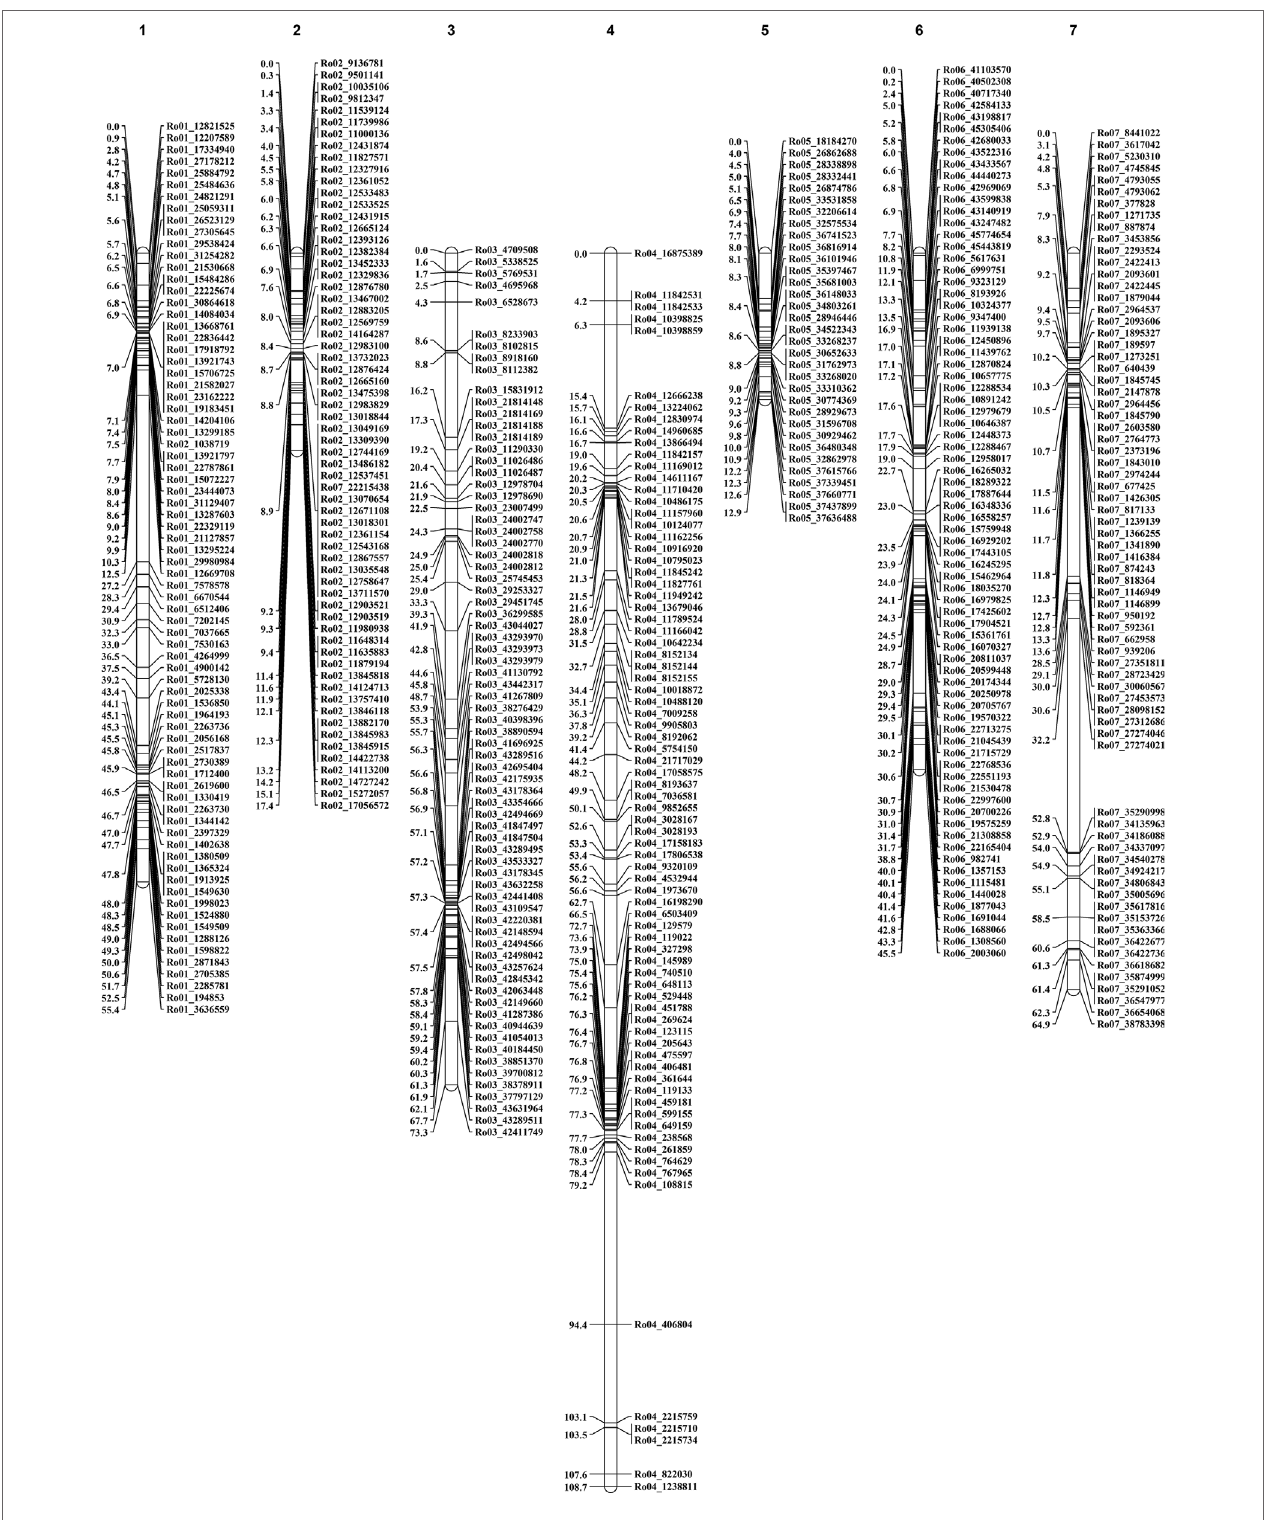
FIGURE 1 | Rubus idaeus genetic map for Annual-Fruiting (AF) parent NC493. The vertical bars represent linkage groups, and the lines across the bars represent genotyping by sequencing (GBS) marker position in the map. The scale on the left represents the genetic distance in centiMorgans (cMs). Only markers that segregated according to the Mendelian ratio at p < 0.005 were employed for the map construction with Joinmap v5.0 ® (Van Ooijen and Voorrips, 2001). Each SNP marker was named according its physical position (right-hand side) in the